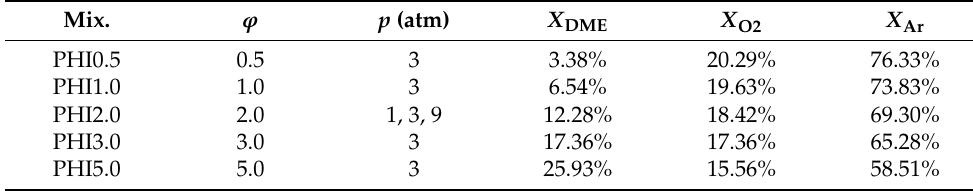
Figure 1. Diagram of the high-pressure shock tube facility. Table 1. Summary of experimental conditions.